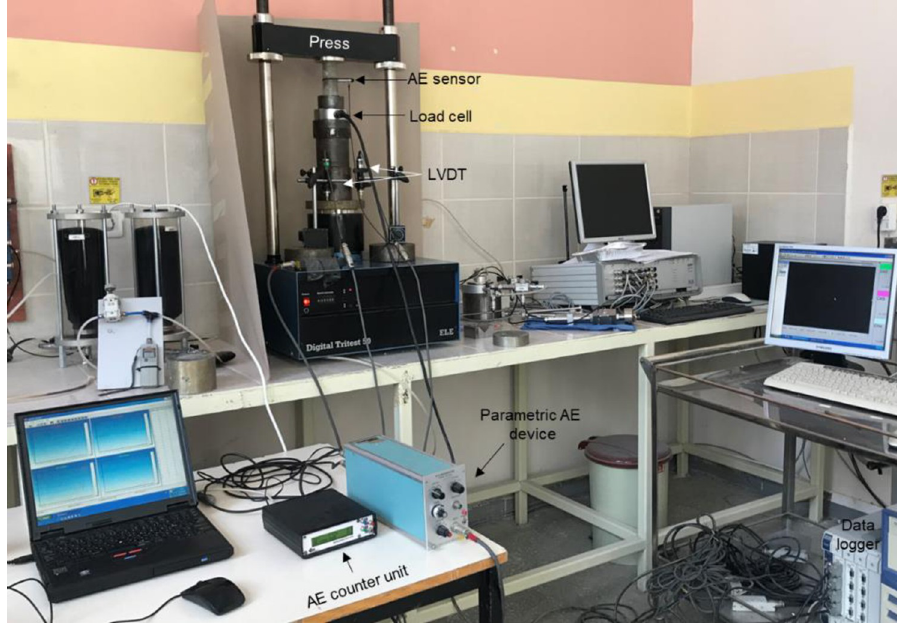
Fig 9. The experimental setup of uniaxial compressive strength test and AE